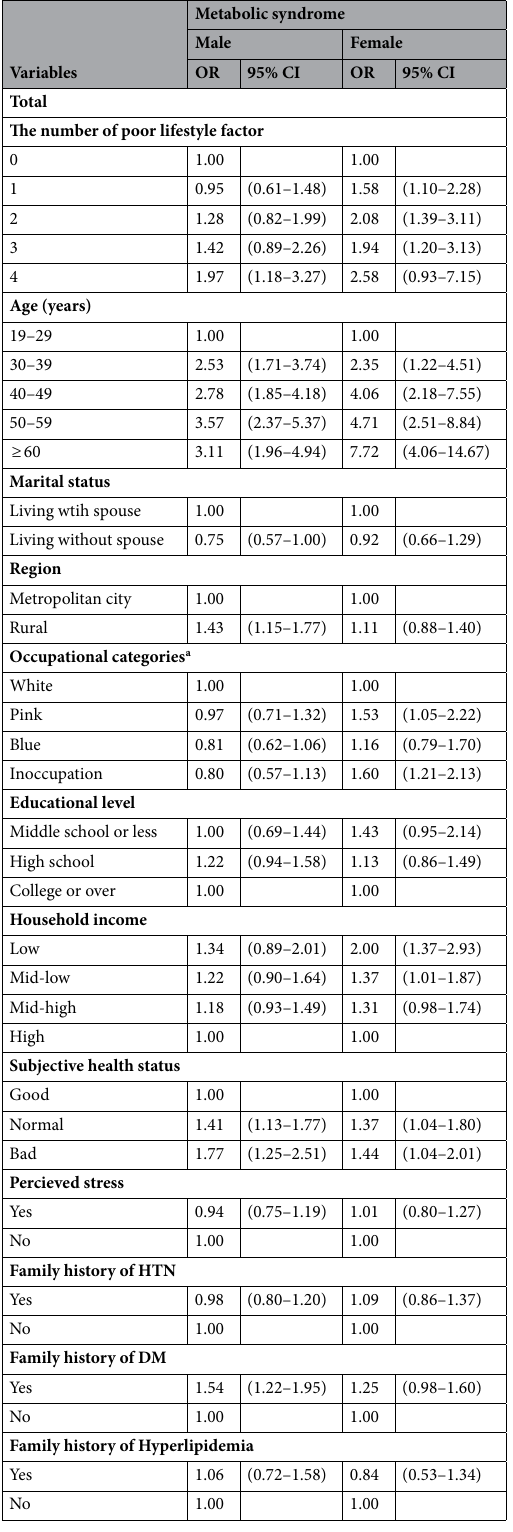
Table 2. Results of factors associated with Metabolic syndrome. a Three groups (white, pink, blue) based on the International Standard Classification Occupations codes. Inoccupation group includes